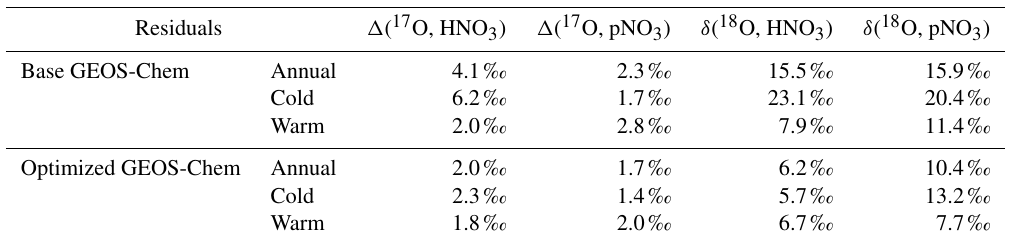
Figure 5. Time series of the monthly mean for observed and calculated δ ( 18 O) for HNO 3 and pNO 3 over ABT147, CTH110, and WST109 CASTNET sites. Calculated δ ( 18 O) using base (black) and optimized (gray) GEOS-Chem are shown in the plot together. Bars indicate the residuals between calculation and observation. Table 2. Summary of the residuals between observed and calculated oxygen isotope deltas by season using the base and optimized GEOS- Chem,